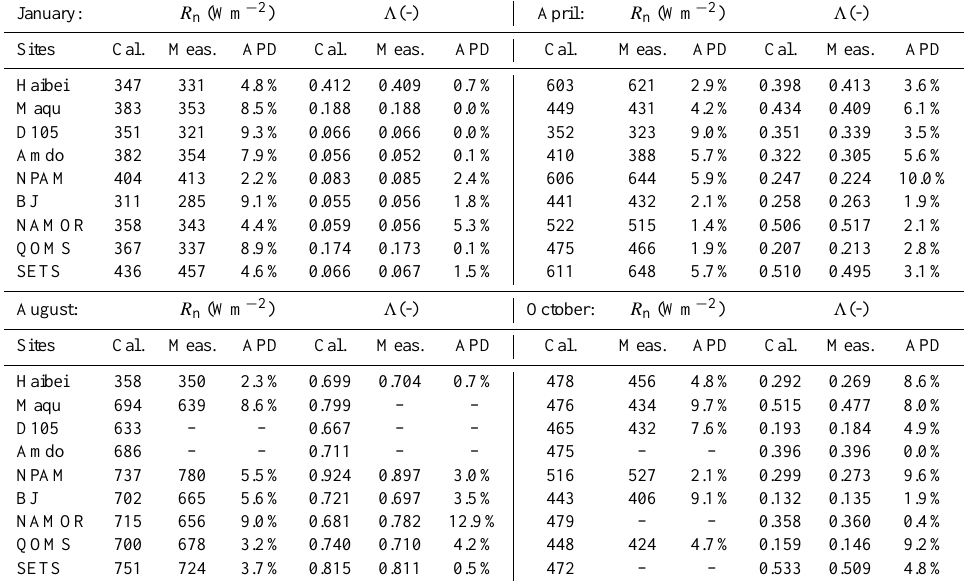
Table 4. Comparison of the derived net radiation flux R n and evaporative fraction 3 (Cal.) vs. the values measured (Meas.) at the Tibetan Plateau with absolute percent difference (APD) in